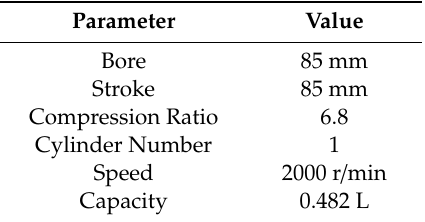
Table 1. K5A hydrogen engine dimensions.